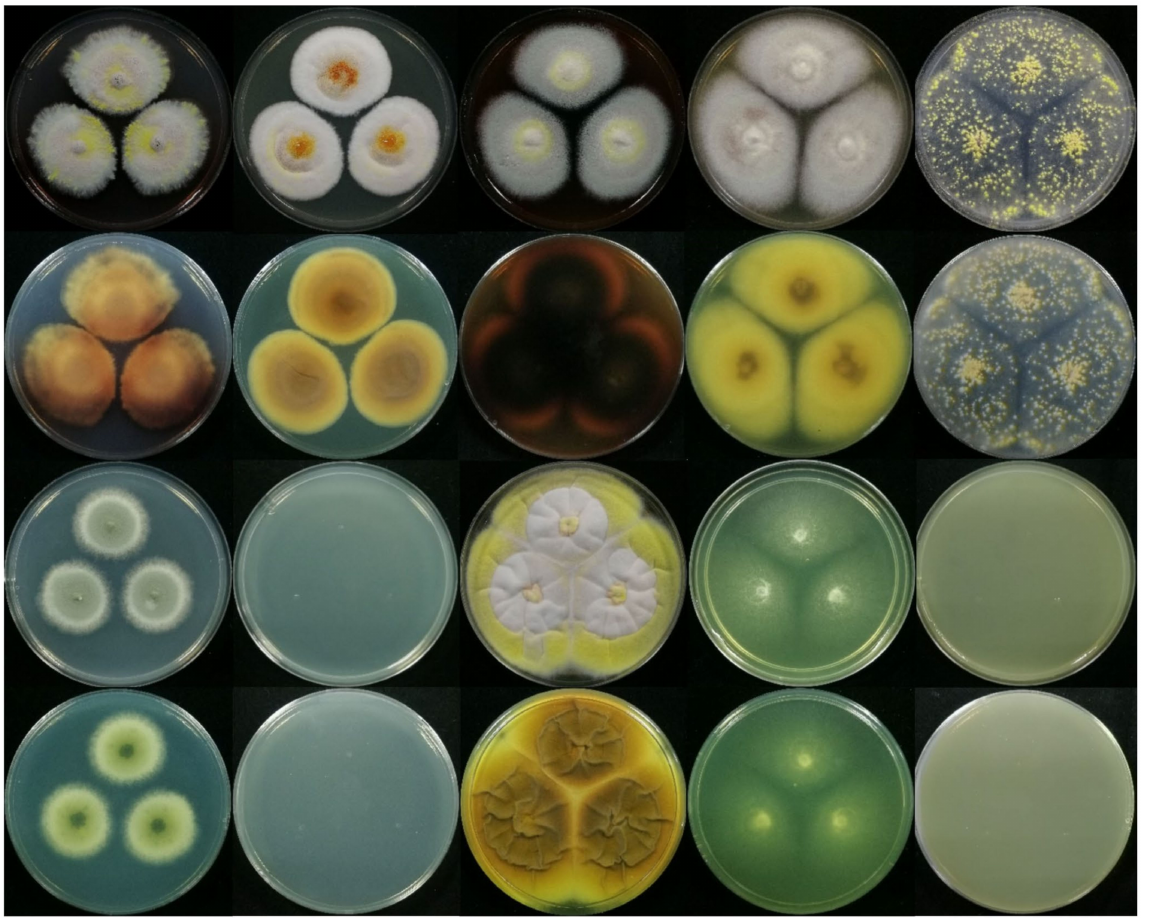
Figure 5. Macromorphological characters of strain JP-NJ4 (Inoculation at 25 ◦ C for 14 days). Colonies from left to right: (the top two rows) CZ, CYA, MEA, MEAbl, OA, and the reverse side correspond- ing to these media; (the bottom two rows) DG18, CYAS, YES, CREA, HAY, and the reverse side corresponding to these media (the background color is